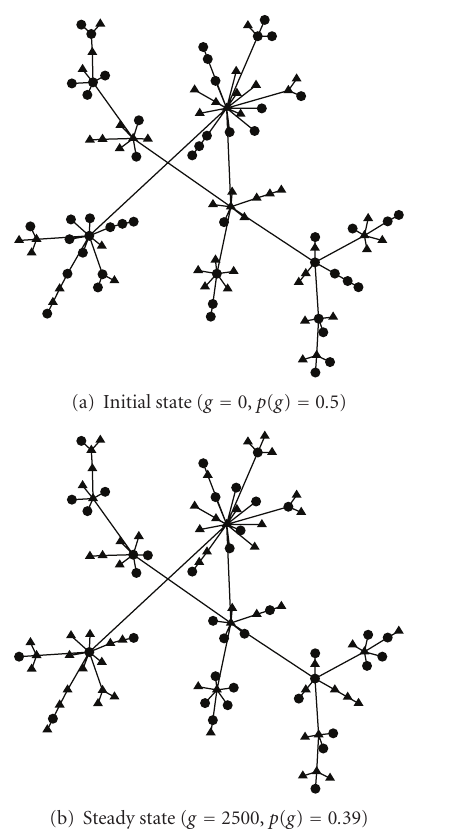
Figure 9: An example of topological structure with transition of strategy distribution (a scale-free network with N = 100 and m = 1).